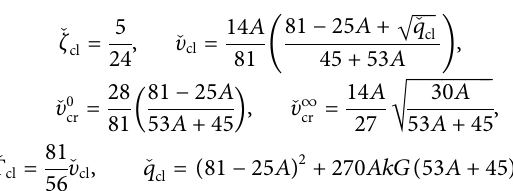
Frontiers in Applied Mathematics and Statistics |